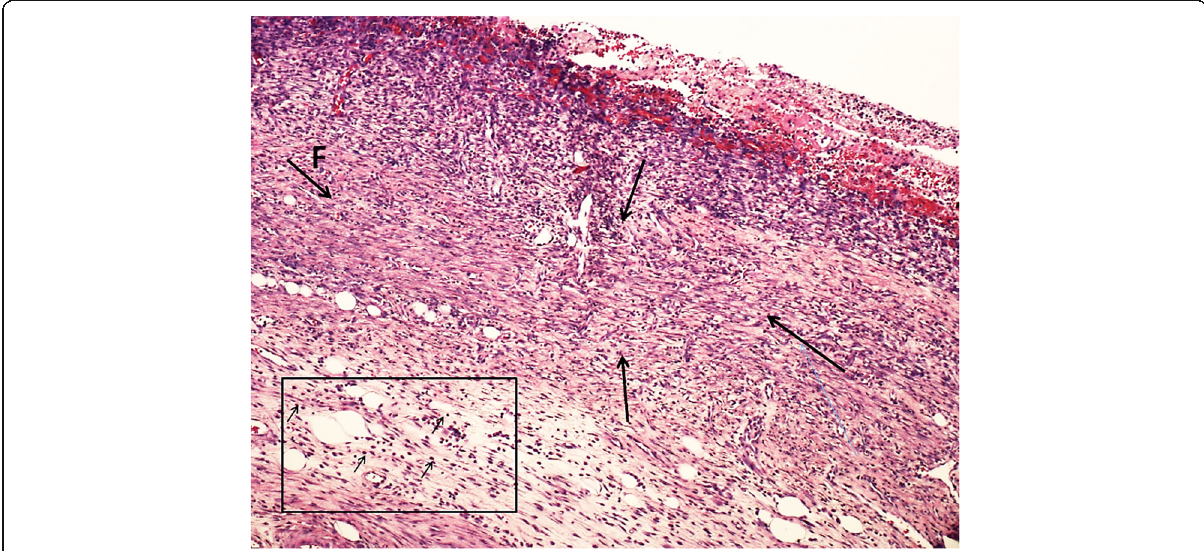
Fig. 5 Histology image of the healed wound with severe interstitial lymphocytic infiltration ( small arrows in the box) and dermal fibrosis (F and large arrows) (group